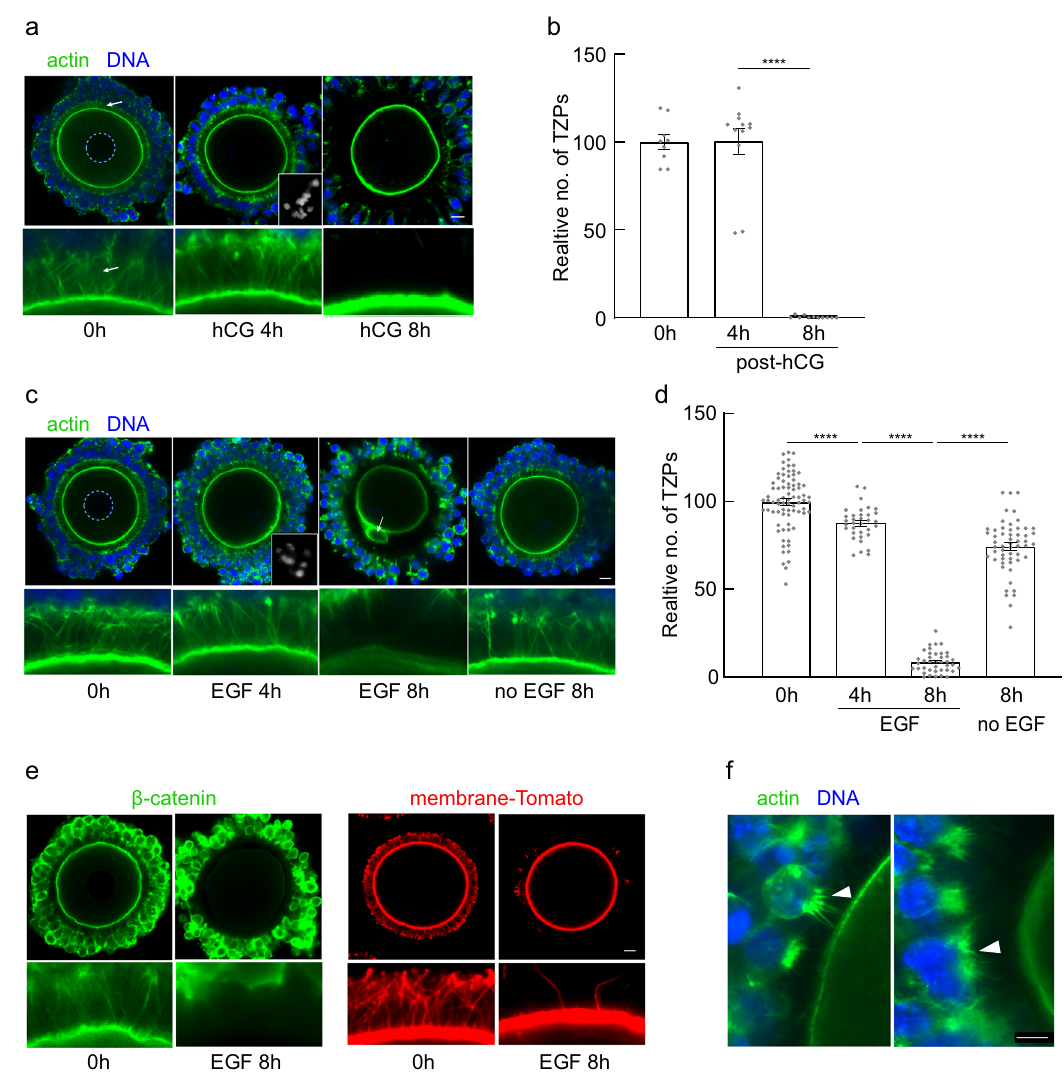
Fig. 2 EGF triggers retraction of TZPs. a Confocal images of cumulus-oocyte complexes (COCs) during maturation in vivo. TZPs (arrows) are stained using the F-actin binding peptide, phalloidin. Lower panels show enlarged portion of corresponding upper panels. 0 h: Prior to maturation. Dashed circle outlines the oocyte nucleus (germinal vesicle). 4 h: 4 h after injection of hCG, an LH analogue. Inset shows condensed oocyte chromosomes, con fi rming that GVBD has occurred. 8 h: 8 h post-hCG. b Mean and SEM of number of TZPs at the indicated times after hCG injection, normalized to the number